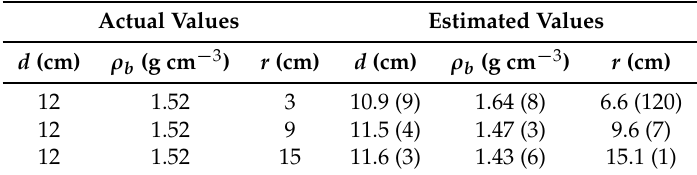
Table 3. Estimated depths, densities and radii values for disk sources of varying radii buried in the dry soil at a fixed depth of 12 cm. The values in parentheses are the relative error in